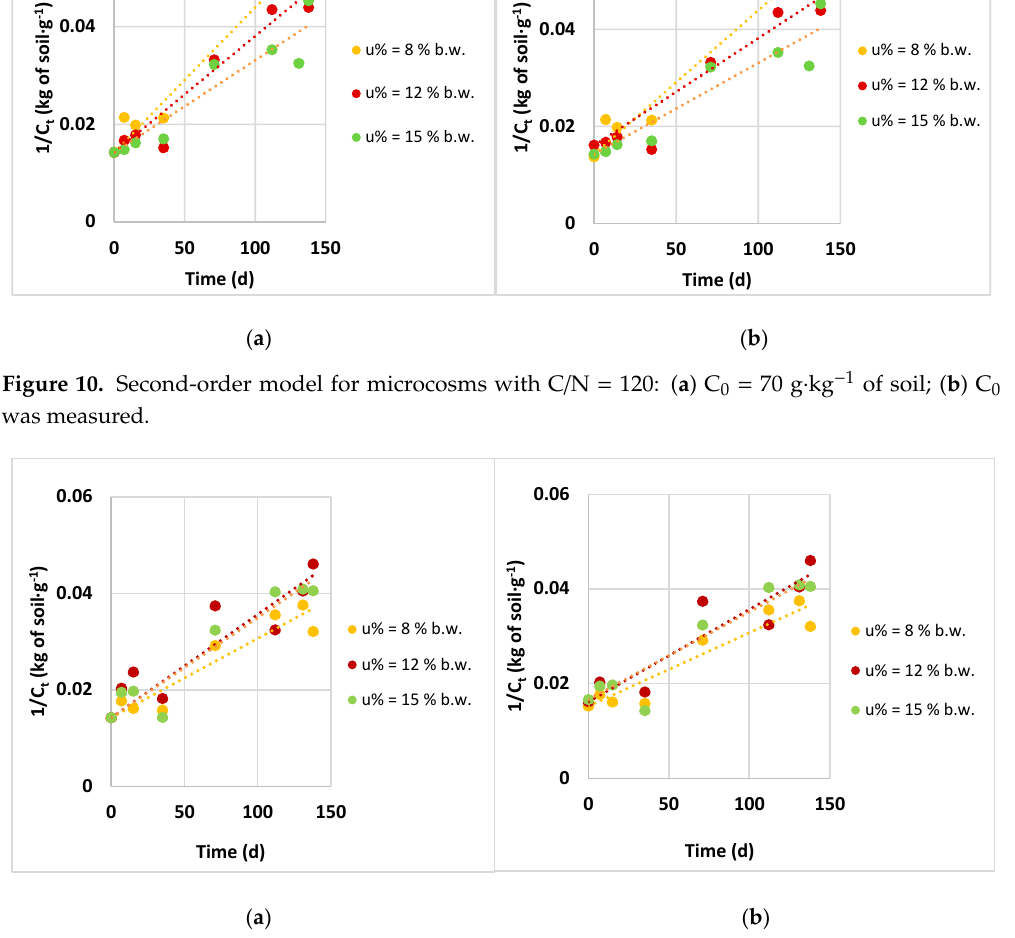
Figure 11. Second-order model for microcosms with C/N = 180: ( a ) C 0 = 70 g · kg − 1 of soil; ( b ) C 0 was measured.